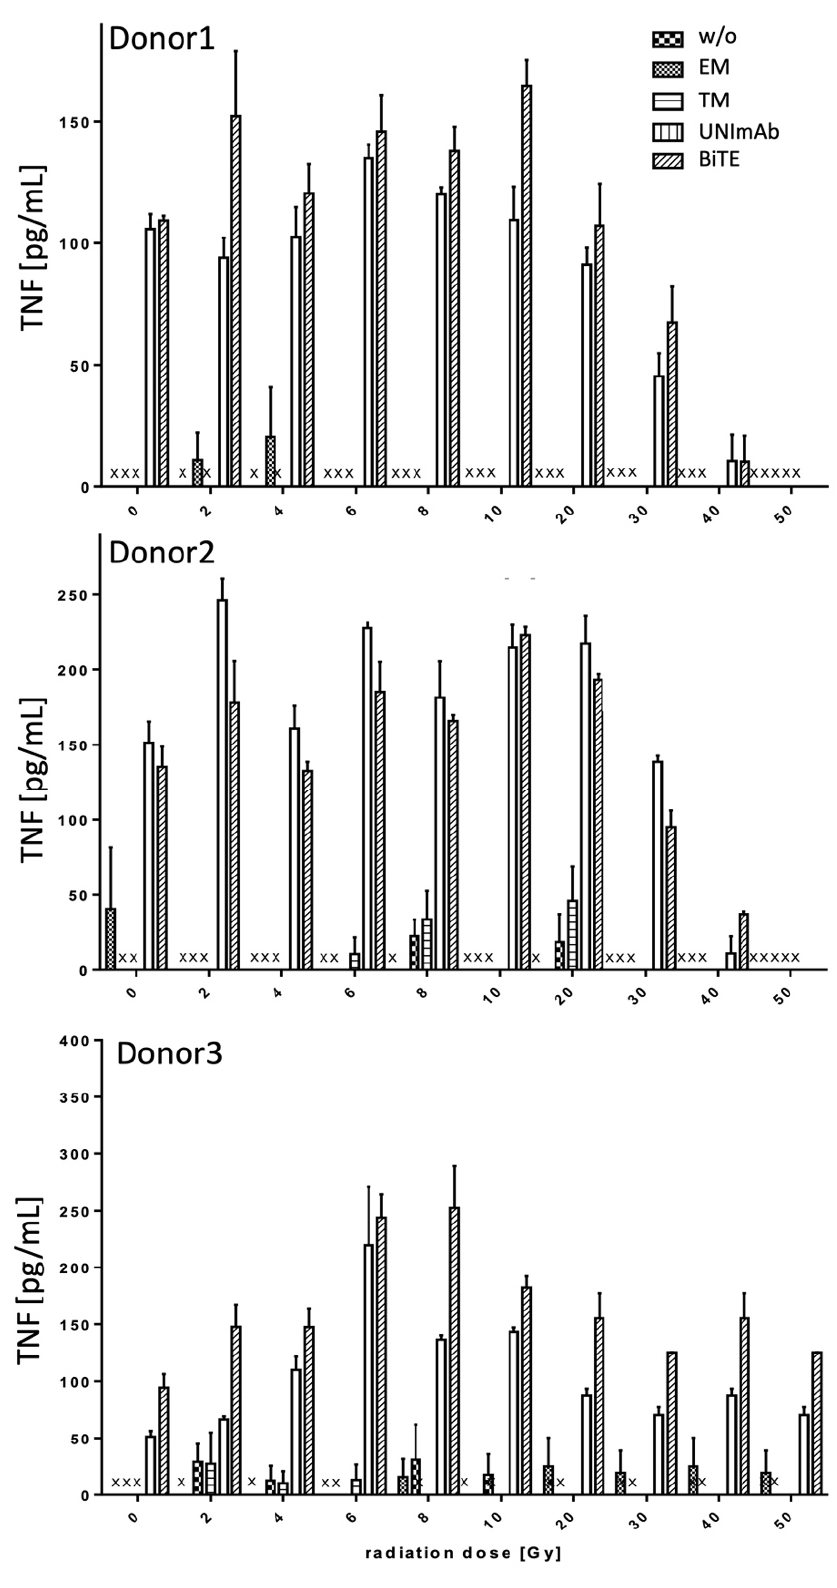
Figure 6. Release of Tumor Necrosis Factor (TNF). The concentrations of TNF were measured in supernatants via ELISA. The mean cytokine concentrations ± SD of triplicates for three different donors are shown. (x… not detectable).